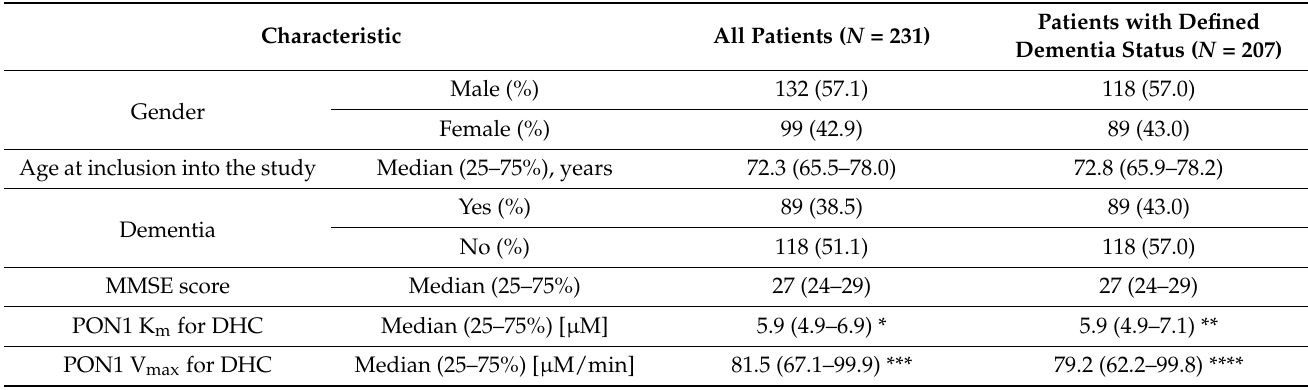
Table 1. Characteristics of PD patients in the present